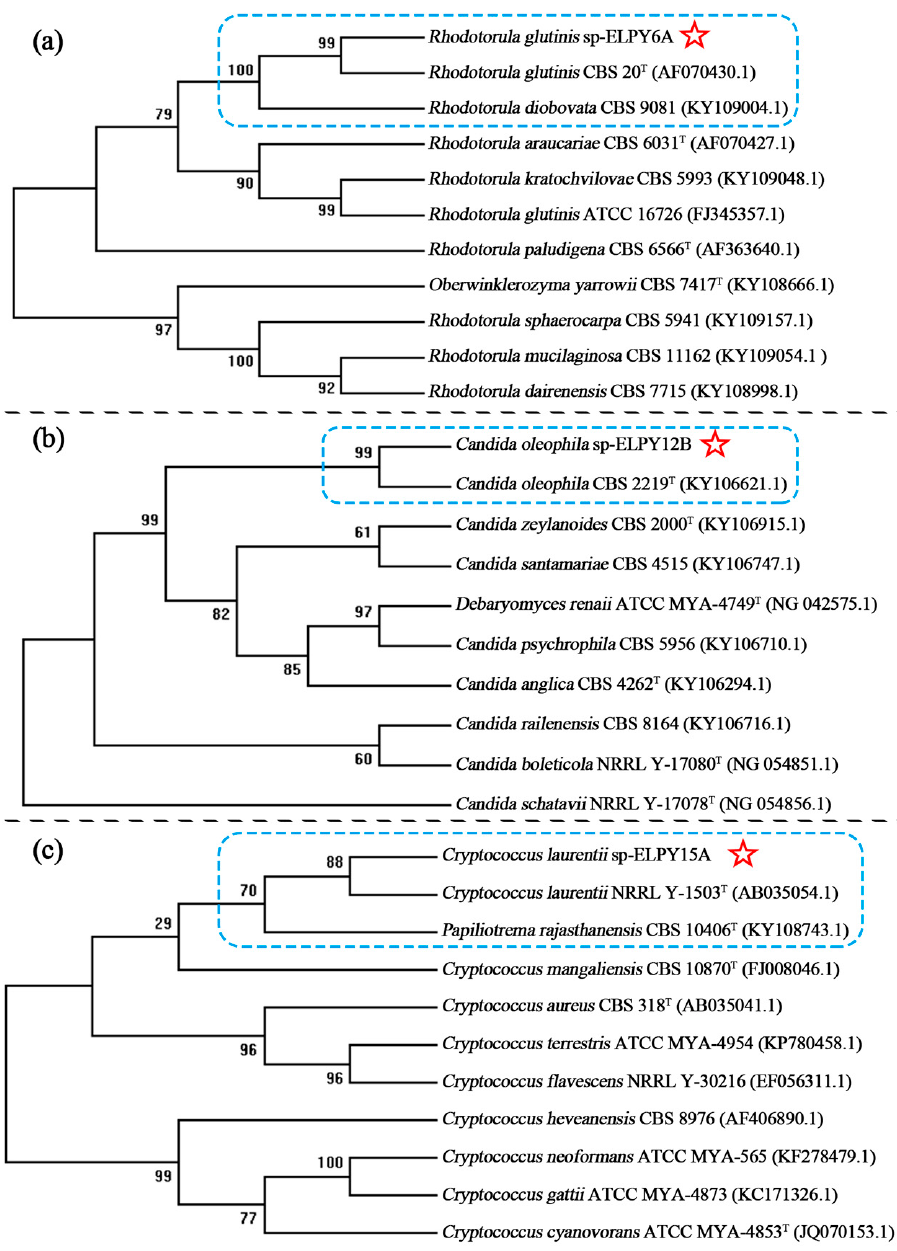
Figure 1. The phylogenetic trees of 26S rRNA D1/D2 domain sequences from the three strains. The types of strains from ATCC, NRRL, and CBS are marked with a superscript T letter. ( a ) is the phylogenetic tree of Rhodotorula glutinis sp-ELPY6A, ( b ) is the phylogenetic tree of Candida oleophila sp-ELPY12B, ( c ) is the phylogenetic tree of Cryptococcus laurentii sp-ELPY15A. red star is the candidate yeast with genetic differences.